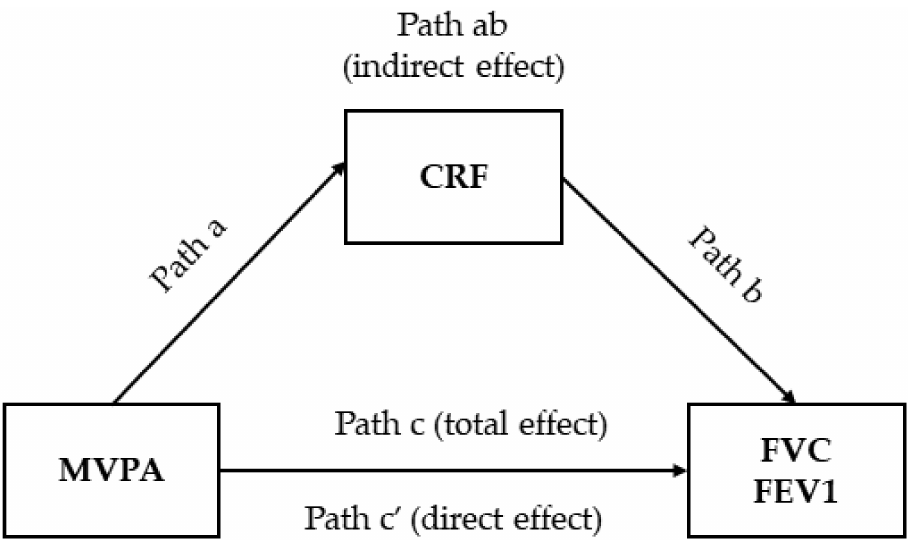
Figure 1. Cardiorespiratory fitness structural equation models of the relationships between moderate- to-vigorous physical activity and lung function. MVPA, moderate-to-vigorous physical activity; CRF, cardiorespiratory fitness; FVC, forced vital capacity; FEV1, forced expiratory volume in 1